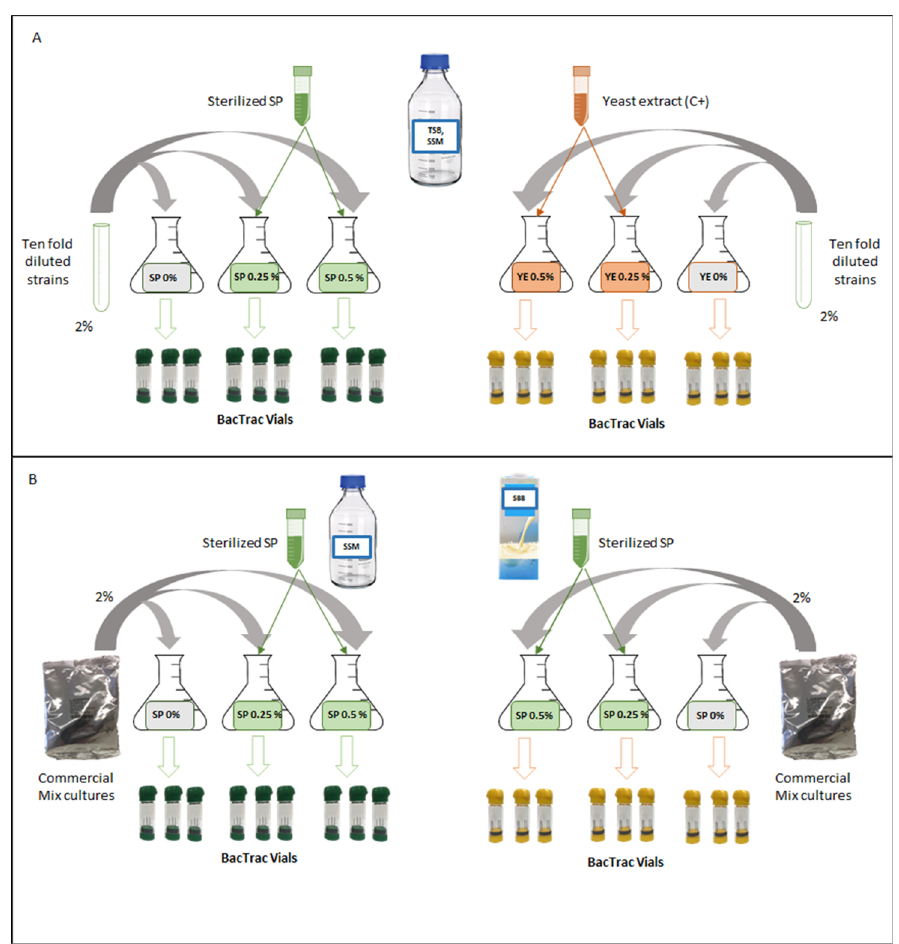
Figure 1. Schematic representation of the experimental design of this study: (A) Strains fermentation in TSB and SSM, (B) Commercial mix culture fermentation in SSM and SBB.